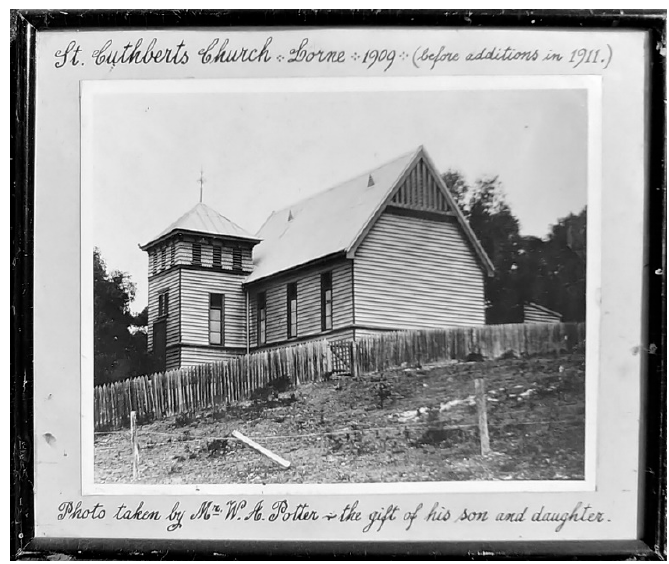
Figure 4. Photo of St. Cuthbert’s church c. 1909, prior to additions. Source: image reproduced with the permission of Sam Coulson, Treasurer, Lorne Anglican-Uniting Church, Lorne (original photo taken by W. A. Potter).